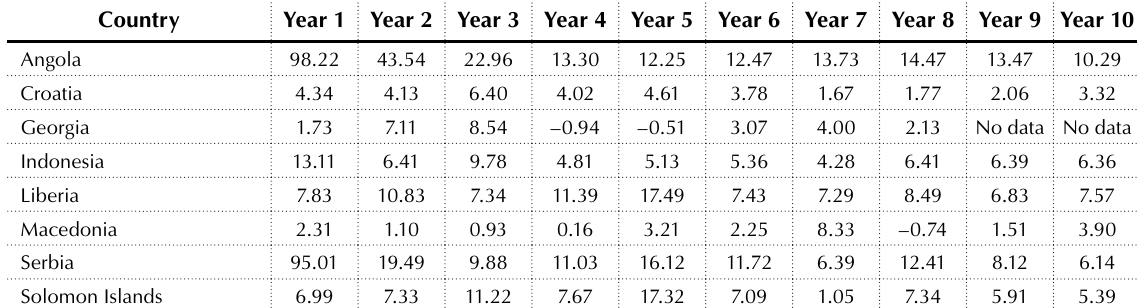
Source: Wolrd bank Open Data.